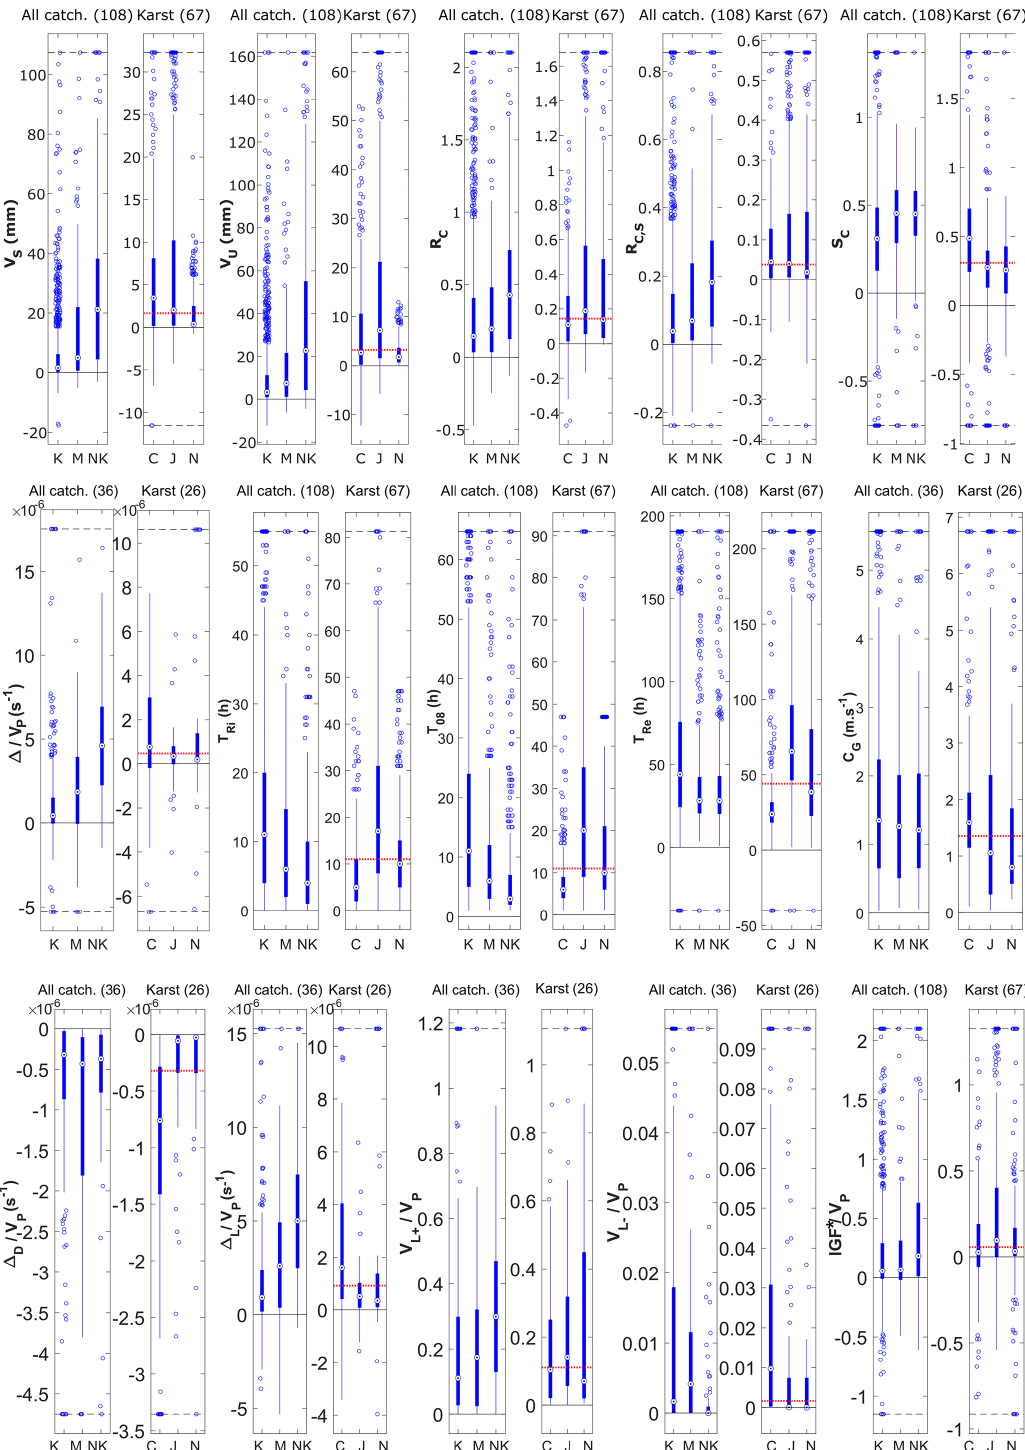
Figure 6. Distribution of hydrological descriptors, grouped by geology type (K: karst, M: mixed, NK: non-karst) and by location for karst catchments (C: Cévennes, J: Jura, N: Normandy). First row: water-balance descriptors; second row: hydrograph-shape descriptors; third row: lateral-exchange descriptors. Red dotted lines show the median value of karst catchments for the whole sample. Values beyond black dashed lines are represented on the